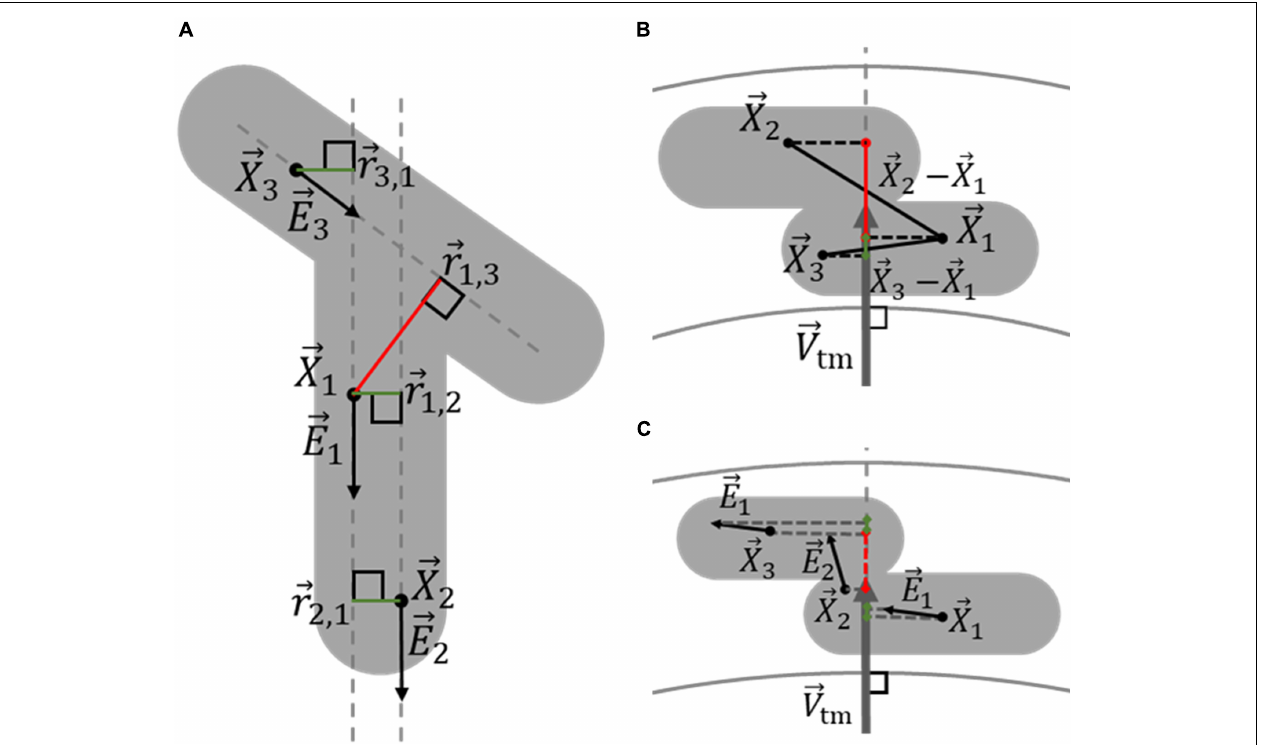
FIGURE 5 | Determination of the likelihood that two voxels belong to the same nucleus, based on their orientation and location. (A) Voxels within a multiple-nucleus structure, shown in gray, can still likely be part of the same elongated structure, and thus the same nucleus, even when relatively far apart. Voxels 1 and 2, with −→ −→ −→ −→ −→ −→ locations X 1 and X 2 , respectively, have similar orientations, given by E 1 and E 2 , respectively. Because the line between X 1 and X 2 is relatively in line with both −→ −→ −→ −→ E 1 and E 2 , vectors r 1 , 2 and r 2 , 1 are both short enough to produce high likelihoods that voxels 1 and 2 belong to the same nucleus, indicated by the green −→ −→ −→ −→ lines. On the other hand, because the orientation of voxel 3, E 3 , is dissimilar to that of the line between X 1 and X 3 , r 1 , 3 is too long for voxel 1 and 3 to likely be −→ part of the same nucleus, indicated by the red color, even though r 3 , 1 is small. (B) The transmural distance between voxels influences whether they are likely part of −→ −→ −→ the same VSMC layer, and thus the same nucleus. The projection of X 1 - X 3 on V tm is relatively small, making it likely that voxel 1 and 3 belong to the same VSMC −→ −→ −→ layer. Conversely, the projection of X 1 - X 2 on V tm is relatively large, making it unlikely that voxel 1 and 2 belong to the same VSMC layer. (C) The transmural components of voxel orientations indicate whether voxels are oriented in the axial-circumferential plane of the vessel, similar to VSMCs, and whether they likely −→ −→ −→ −→ belong to a specific nucleus. The green and red colors of the projections of E 1 , E 2 , and E 3 on V tm indicates voxels 1 and 3 are oriented primarily in the axial-circumferential plane, while voxel 2 is